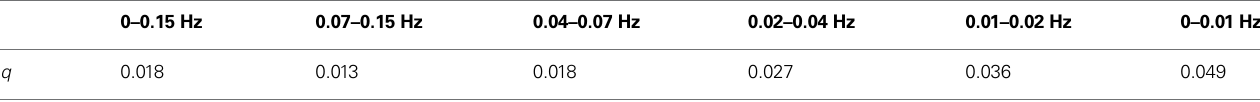
Table 2 | Reproducibility of the ISCs across the two scanning